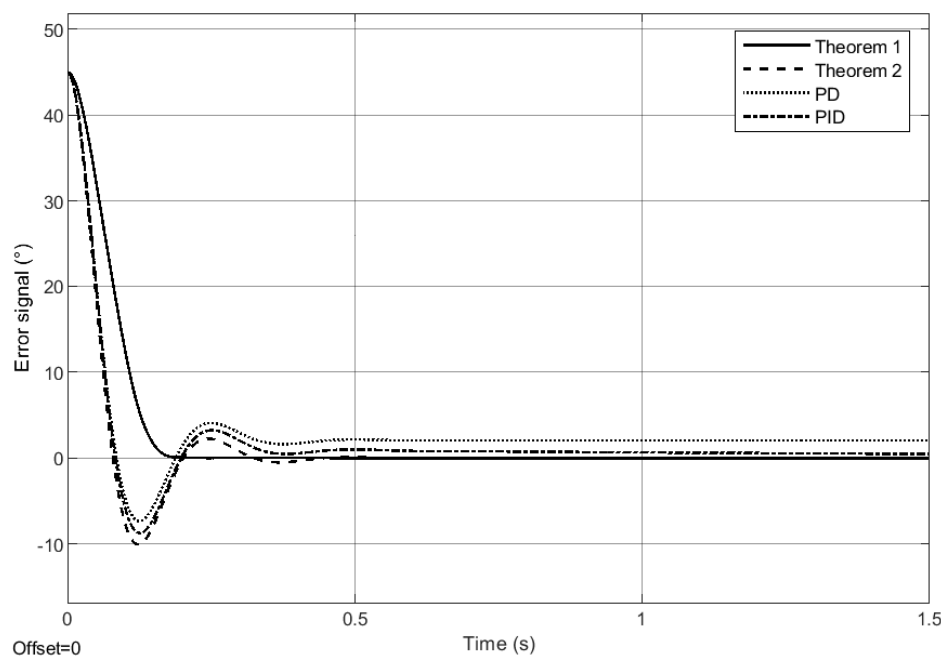
Figure 2. Error signals with diverse controllers in θ 1 for a single degree of freedom robot